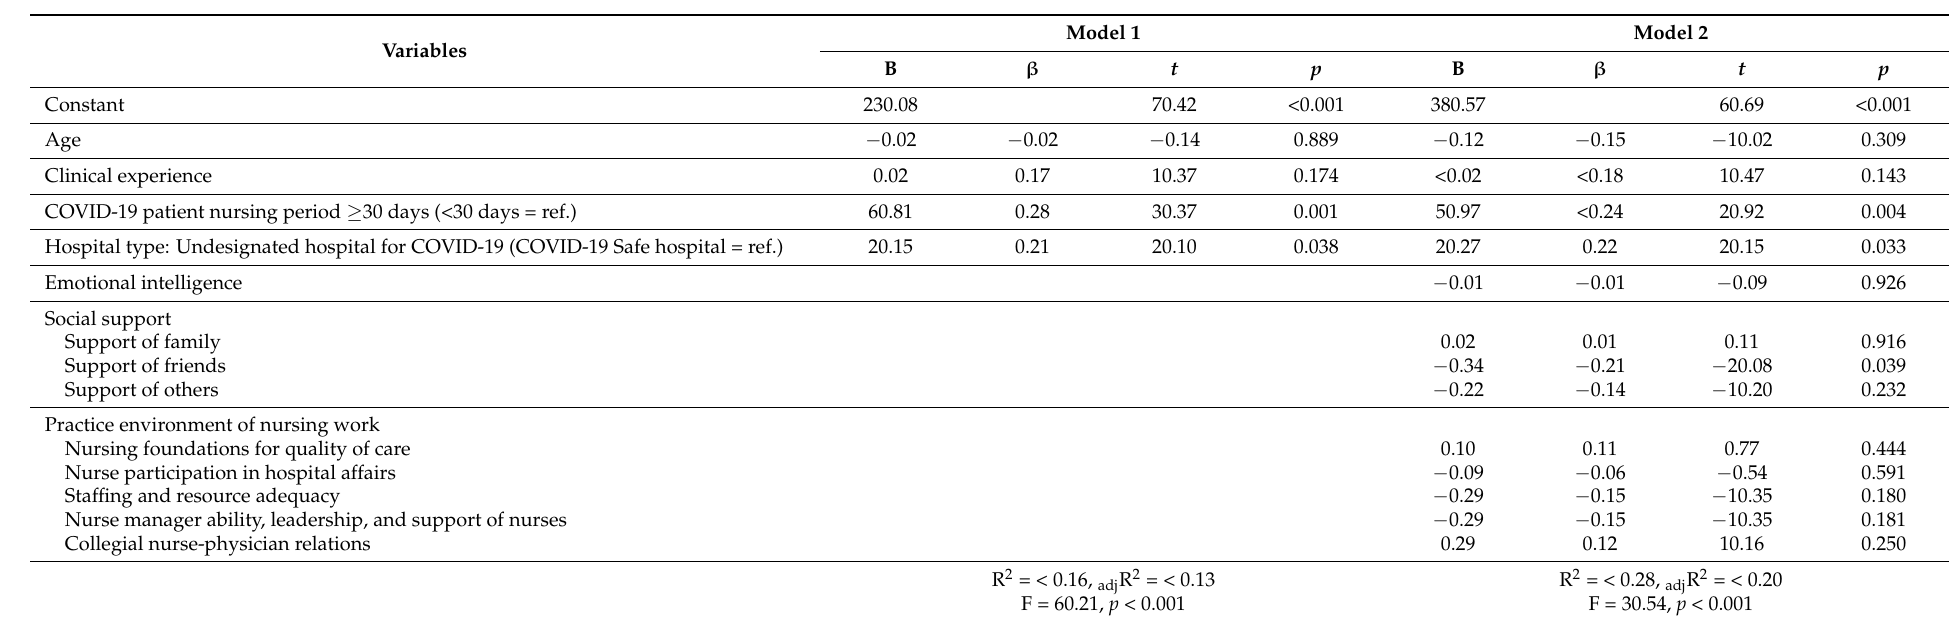
Table 3. Influencing factors on secondary traumatic stress (N =